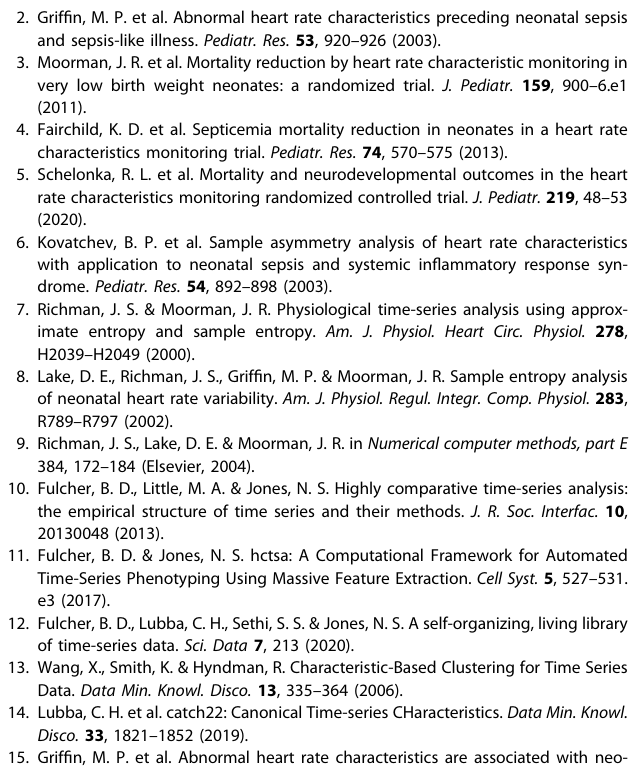
Fig. 7 Sankey plot of the computational approach. Beginning with 3555 operations representing 11 families of algorithms, we ended with 20 clusters each represented by a single